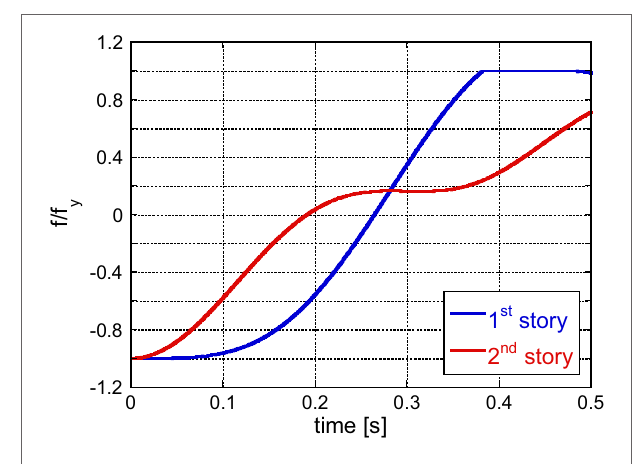
FigUre 16 | Time histories of the restoring forces in the first and second stories starting from the phase